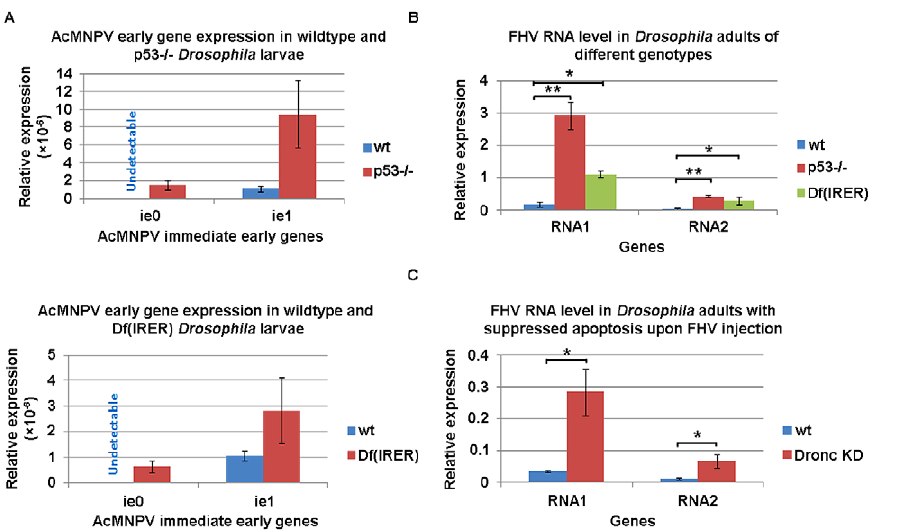
Figure 4. Rapid induction of apoptosis functions to limit viral gene expression and proliferation. A. The mRNA levels of AcMNPV immediate early gene ie0 and ie1 were examined at 6 hr post virus injection by Q-PCR in Drosophila larvae. The data indicate that in both p53 2 / 2 and IRER deficient strains that lack rapid induction of apoptosis, ie0 and ie1 expression levels were dramatically higher than in the wild type strain. Data are shown as mean 6 SD of two to three independent experiments. B. FHV RNA1 and RNA2 levels were examined at 24 hr post injection in wild type, p53 2 / 2 and Df(IRER) adults by Q-PCR. Note the significantly higher levels of RNA1 and RNA2 in p53 2 / 2 and Df(IRER) flies than in wild type flies. C. RNA1 and RNA2 levels were also higher when apoptosis was suppressed by knocking down the upstream caspase Dronc (Dronc KD) in the